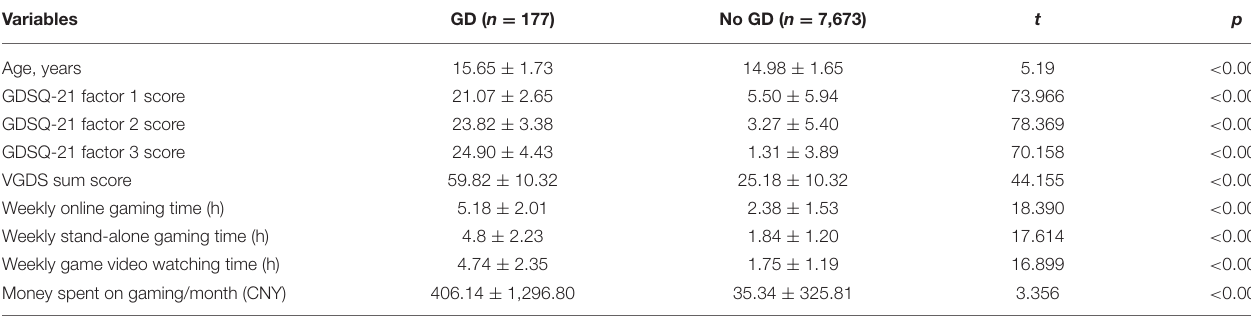
TABLE 5 | Grouping of GD and No GD according to ROC curve cutoffs (mean ± SD).